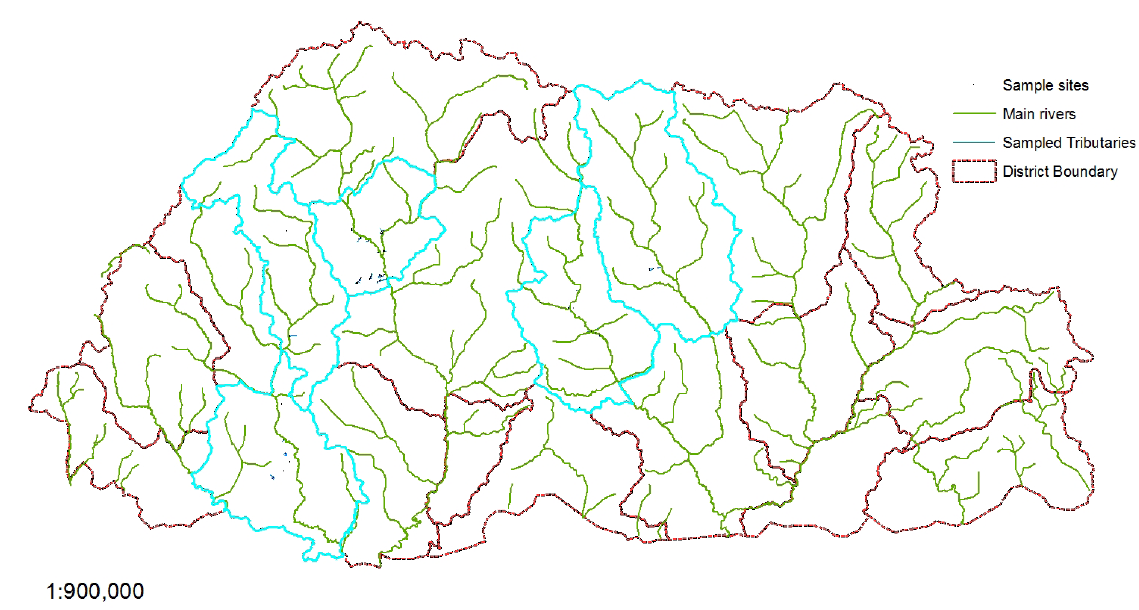
Image 1. Drainage basin of Bhutan with sample sites and highlighted sampled